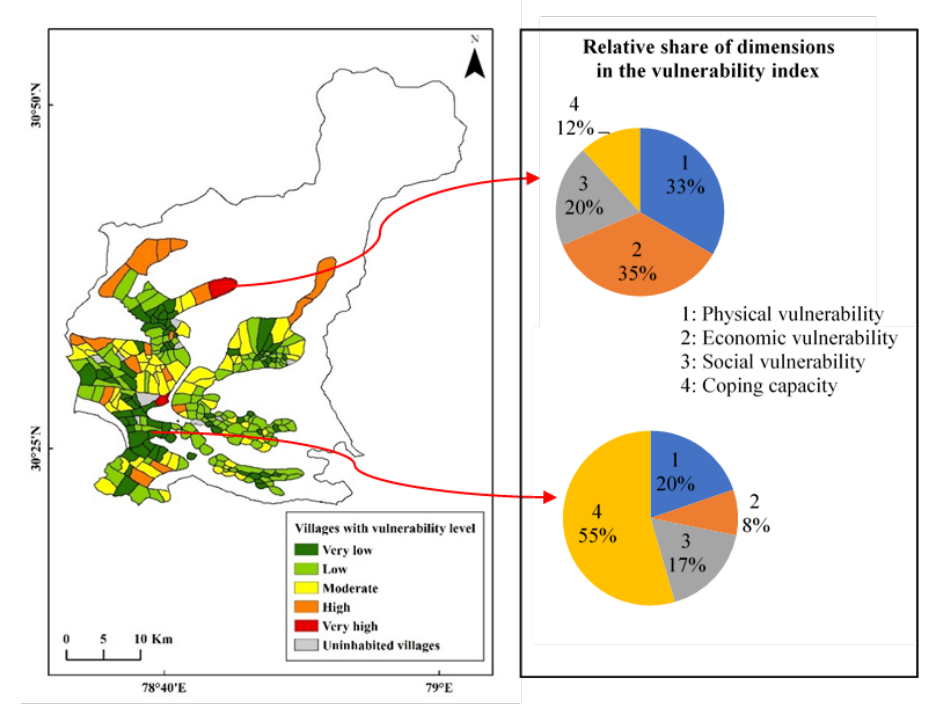
Figure 4. Micro-scale multi-hazard vulnerability assessment for Bhilangana block, Uttarakhand